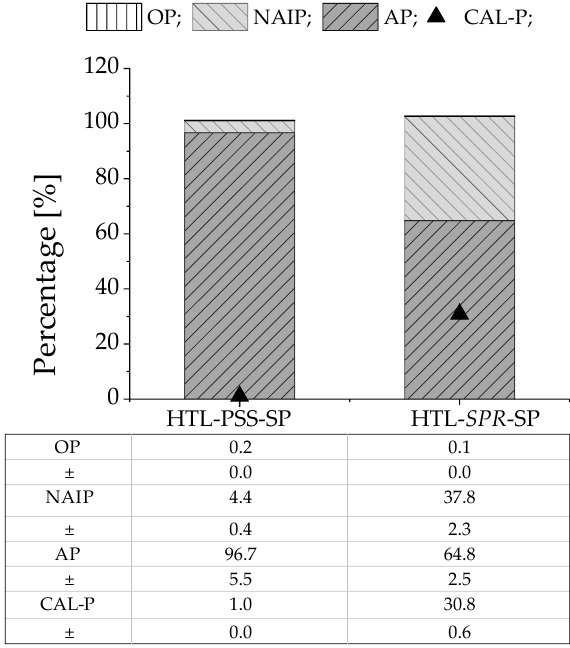
Figure 3. Different forms of phosphate as well as the crop-available form of phosphate in HTL solid phase (MV ± SD of two replicates; error bars are not shown in the figure). The percentage was calculated as follows: (AP(IP, OP, or CAL-P)/TP) × 100%.